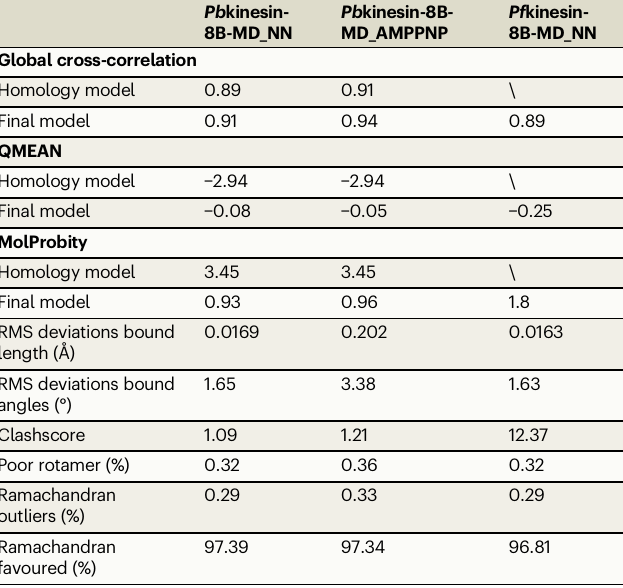
Table 2 | Model building